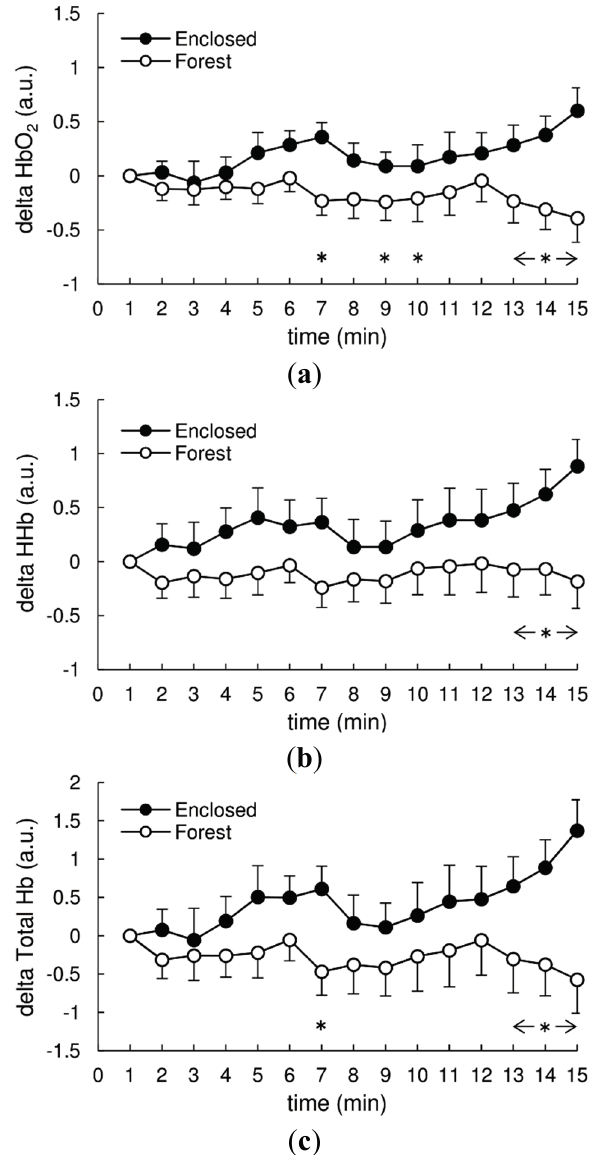
Figure 3. Delta changes in oxygenated hemoglobin ( a ) HbO 2 , deoxygenated hemoglobin ( b ) HHb, and total hemoglobin ( c ) Hb between the Enclosed and Forest conditions. Values are mean ± SEM ( n = 15). * p < 0.05 between the Enclosed and Forest conditions with the Bonferroni post-hoc test.